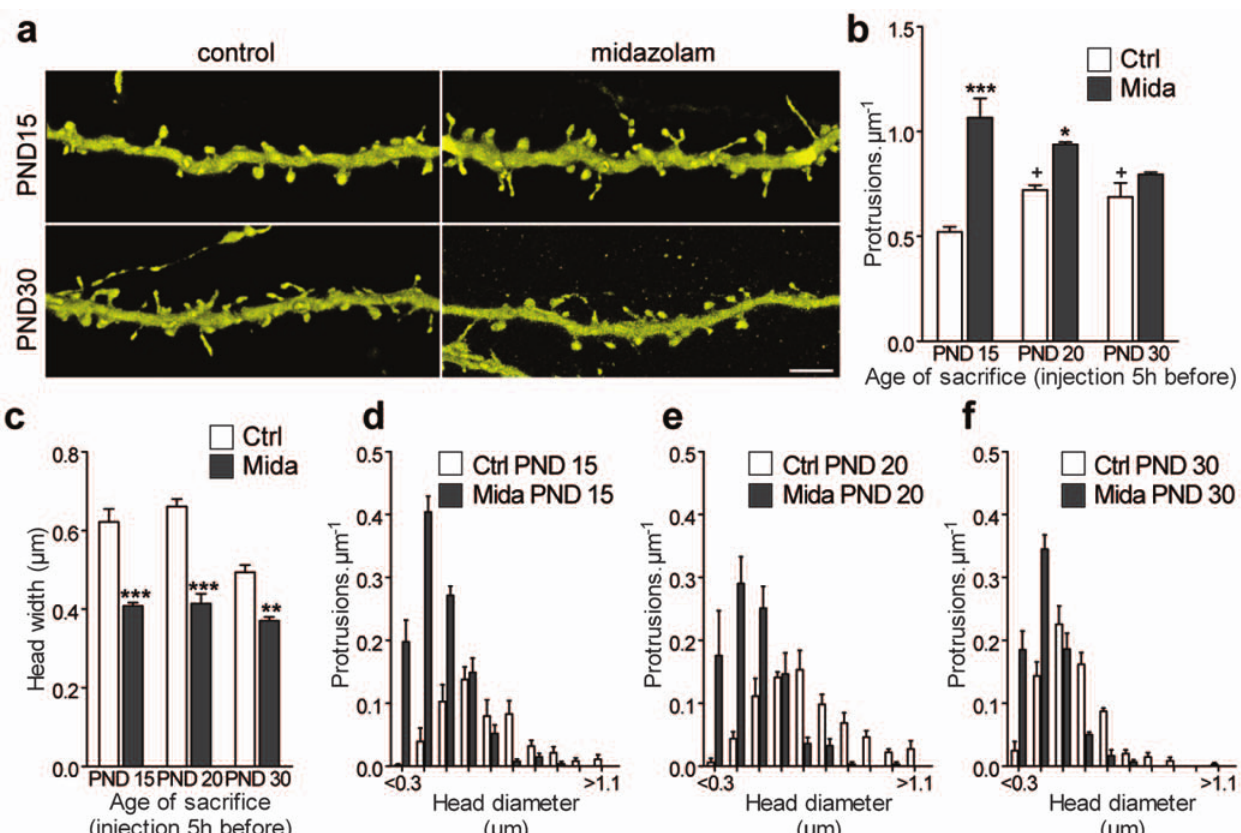
Figure 1. Midazolam increases protrusion density and reduces protrusions head width in the somatosensory cortex invivo . ( a ) Representative confocal images (3D volume rendering) showing apical dendritic shafts in control and midazolam-treated animals at PND 15 and PND 30. Scale bar: 5 m m. ( b ) Protrusion density of pyramidal neurons of the SCC of mice sacrificed at PND 15; 20 and 30 (ctrl; + : P , 0.05, Kruskal-Wallis with Dunn post tests). The increase in protrusion density is age-dependent in midazolam injected animals (Mida) compared to control groups ( n =4 animals per group, 4726 protrusions; two-way ANOVA with Bonferroni post tests). ( c ) Mean dendritic spine head diameter for midazolam-injected (Mida) compared to non-anesthetized mice (Ctrl) at PND 15, 20 and 30 ( n =4 animals per group, 1695 protrusions; ***: P , 0.001, **: P , 0.01, two-way ANOVA with Bonferroni post tests). ( d – f ) Frequency distribution histogram of spine head diameter shows that the effects observed in (b, c) are primarily due to an increase in the number of spines with small heads (each thick mark on x axis is a 0.1 m m